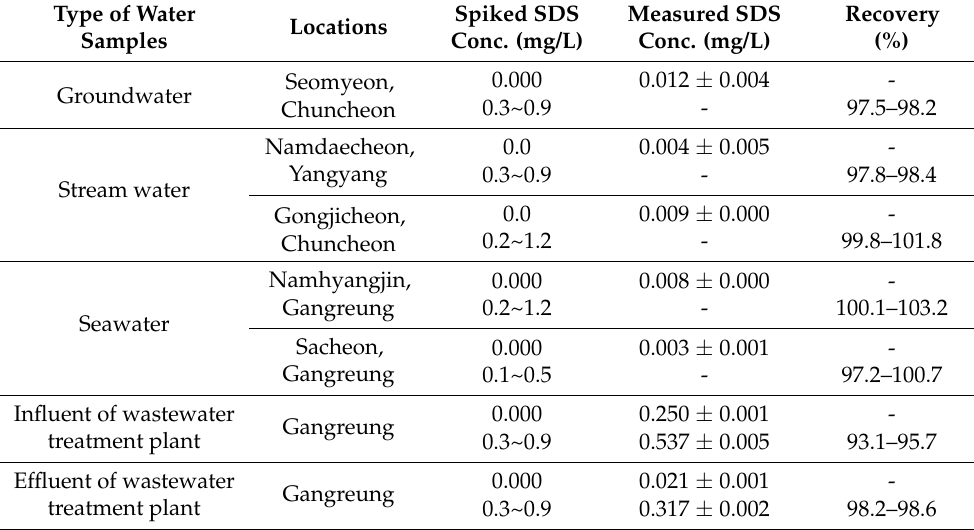
Table 9. Recovery (%) of SDS by MIBK-DCE method for different environmental water samples. Type of